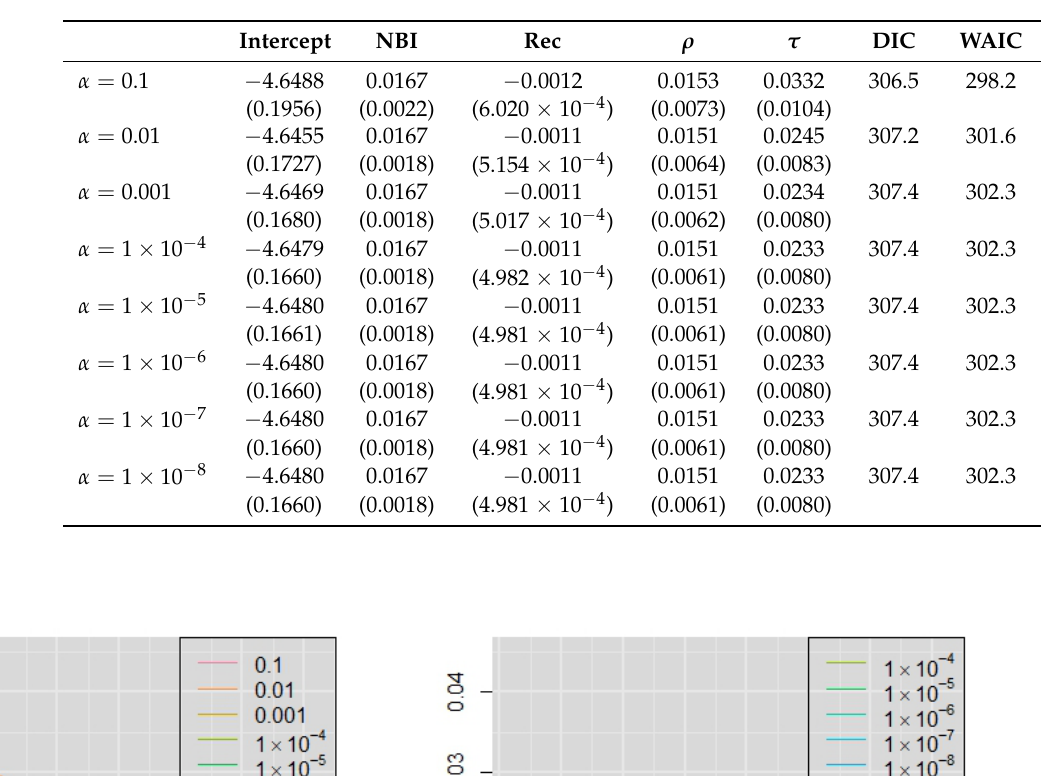
Table 6. Posterior means for parameter estimates together with standard deviations, DIC and WAIC values, for the spatial conditional normal Poisson model in the analysis of the Colombian infant mortality rates data set with different prior distributions for the precision parameter of the random effects.